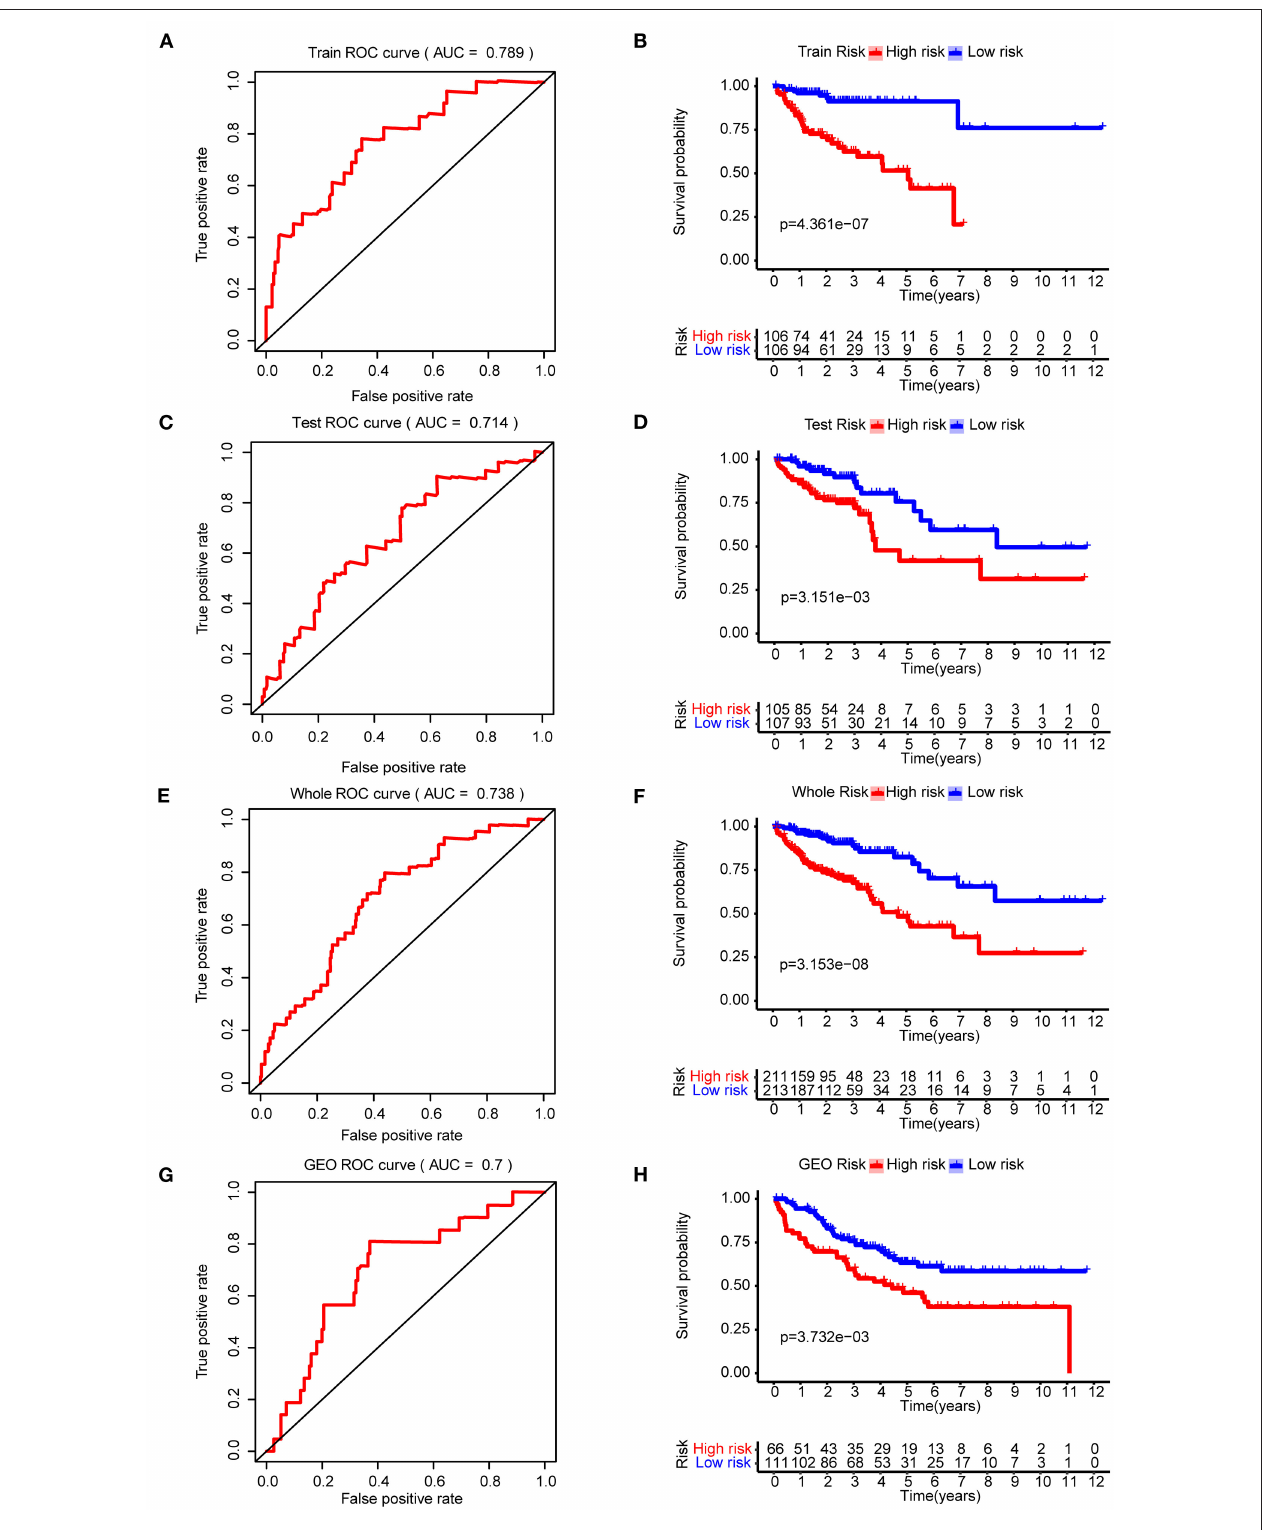
FIGURE 3 | The construction and validation of the five-gene prognostic signature in CRC. Time-dependent ROC analysis and Kaplan–Meier curve of five-gene signature in training set (A,B) , testing dataset (C,D) , the whole dataset (E,F) , and the GSE17536 cohort (G,H) . ROC, receiver operating characteristic.